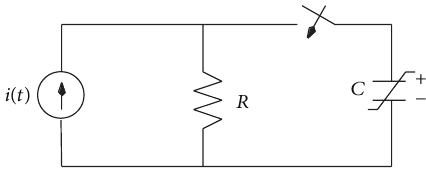
Figure 1: Nonlinear RC